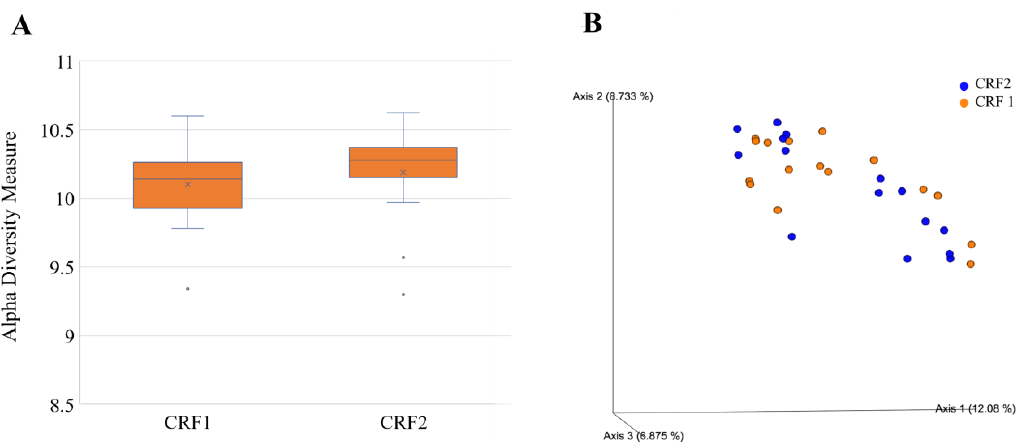
Figure 10. Alpha ( A ) and beta diversity ( B ) in rhizosphere bacteria of ‘Ray Ruby’ grapefruit grafted on ‘Kuharske’ citrange planted in flatwood soils located in Fort Pierce, FL, USA, and grown with different ground-applied fertilizer treatments. Alpha diversity was measured using the Shannon index of rhizosphere bacteria among treatments. Plotted in Figure ( A ) are boxes (interquartile), the median (line within each box), the mean (× within each box), and whiskers (lowest and greatest values). Principal coordinates analysis (PCoA) based on the Bray–Curtis dissimilarity matrix of rhizosphere bacterial samples can be found in Figure ( B ), where colors indicate treatment and include CRF1 (orange) and CRF2 (blue).